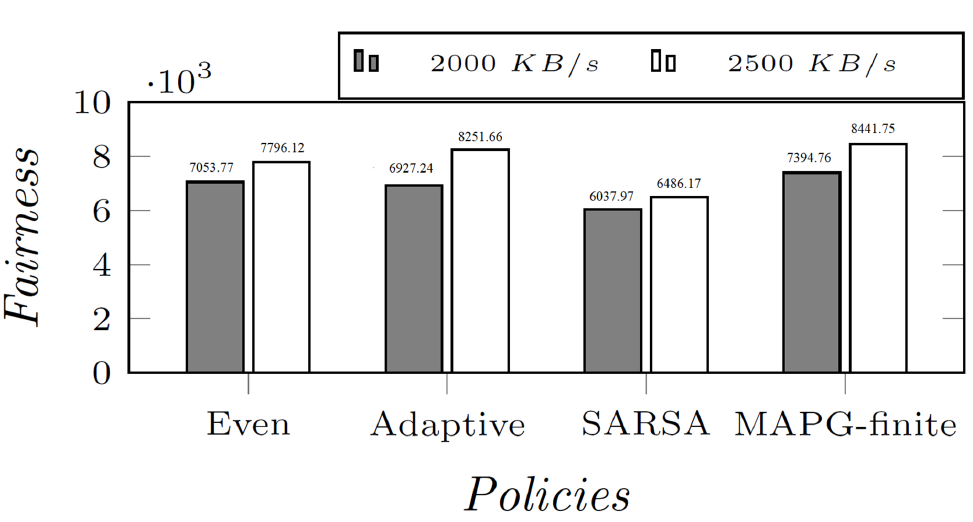
Figure 7. The fairness reward comparison. With the 2000 KB/s download link, MAPG-finite outper- forms “Even” by 4.83%, “Adaptive” by 6.75%, and SARSA by 22.47%. With the 2500 KB/s download link, MAPG-finite outperforms “Even” by 8.28%, “Adaptive” by 2.30%, and SARSA by